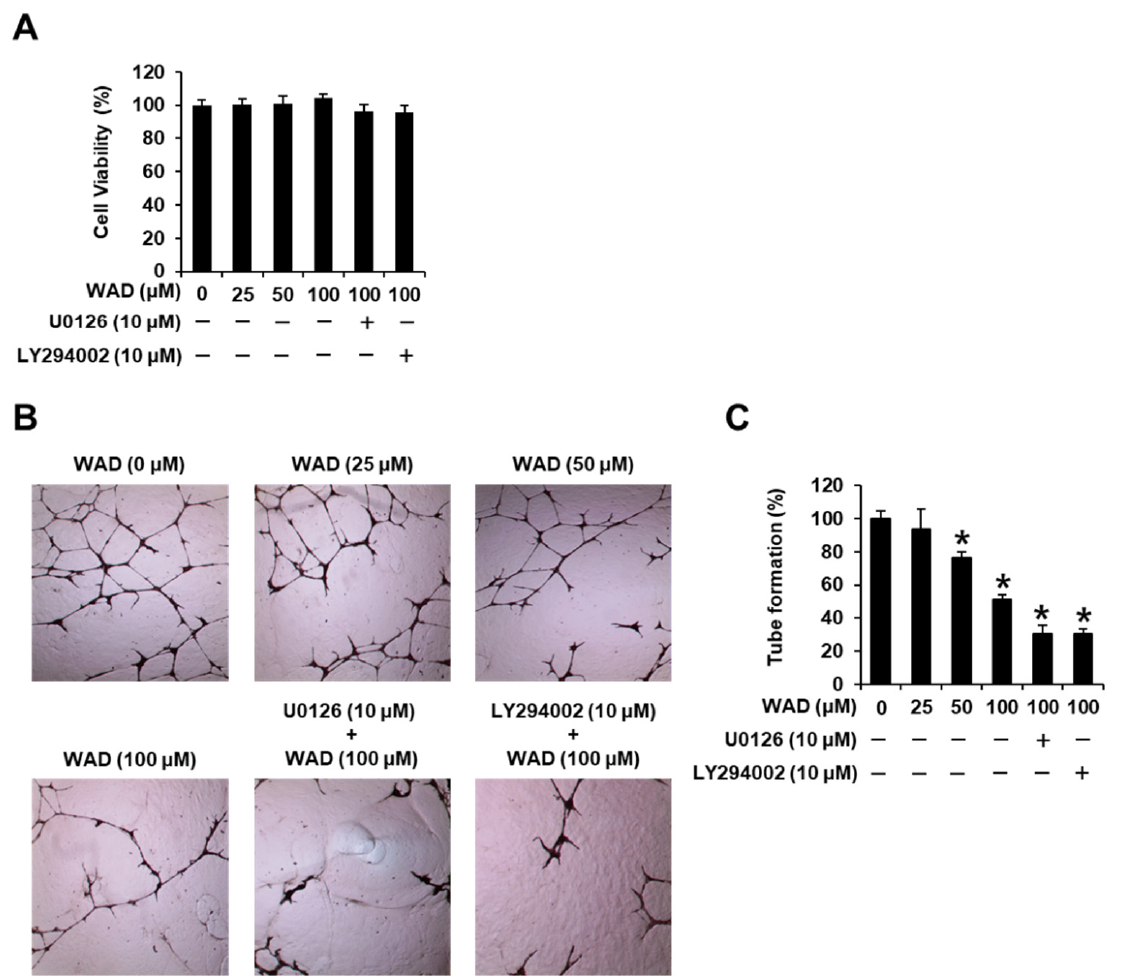
Figure 9. Effects of withagenin A diglucoside (WAD) on cell viability and tube formation in human umbilical vein endothelial cells (HUVECs). HUVECs were treated with WAD (25, 50, and 100 μ M), U0126 (10 μ M), and/or LY294002 (10 μ M) for 24 h. Cells were treated with culture media containing 0.5% DMSO as vehicle controls: ( A ) The MTT assay assessed the viability of HUVECs. ( B ) Repre- sentative photographs of HUVEC tube formation on matrigel at 200× magnification. ( C ) The relative lengths of tubes were quantified using ImageJ software. Data are presented as the mean ± standard error of the mean (SEM). n = 3, * p < 0.05 compared with the control.